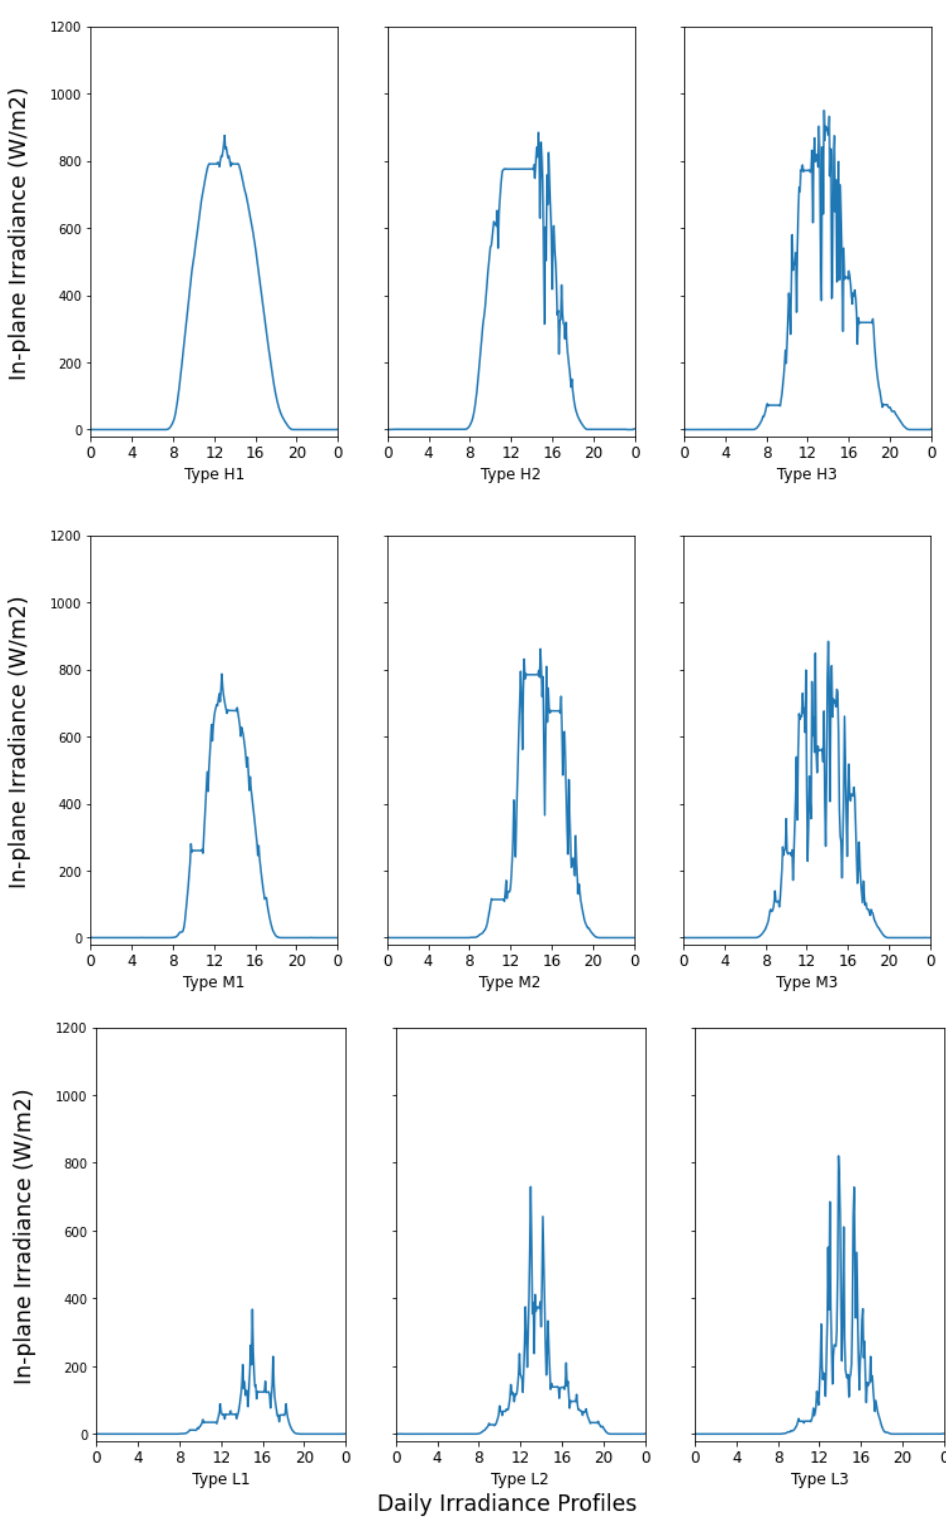
Figure 7. Sample of daily irradiance profiles obtained in the clusters L1, L2, L3, M1, M2, M3, H1, H2 and H3.